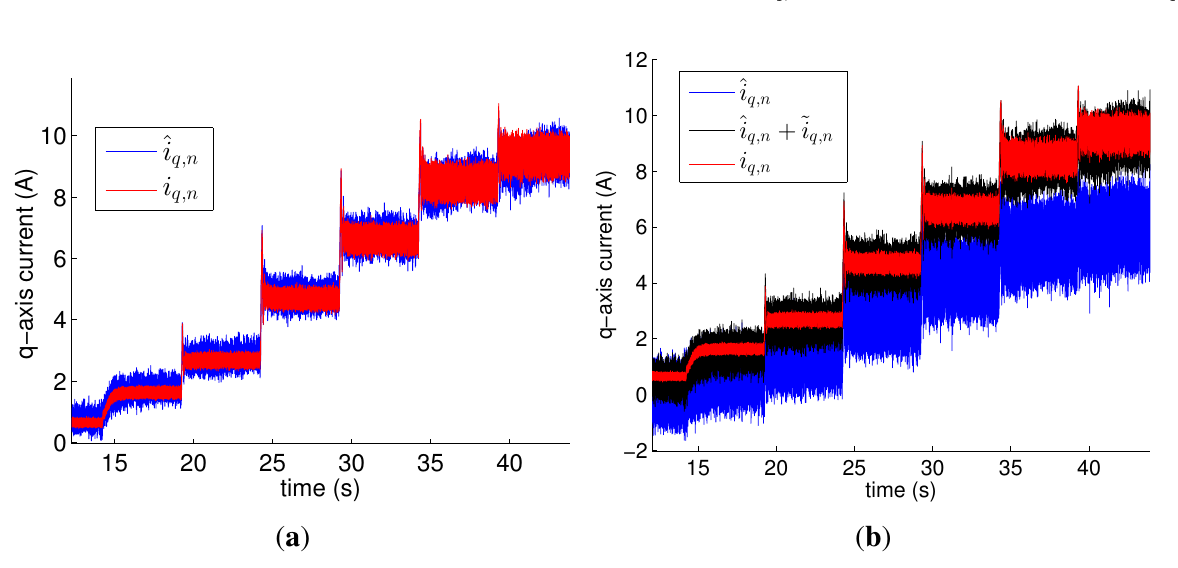
) in healthy motor and estimated values q,n using ( a ) accurate values of parameters; q,n = 8 . 0 mH, L (cid:48) = 4 . 0 mH, and ψ (cid:48) = 0 . 1464 Wb. The q PM d